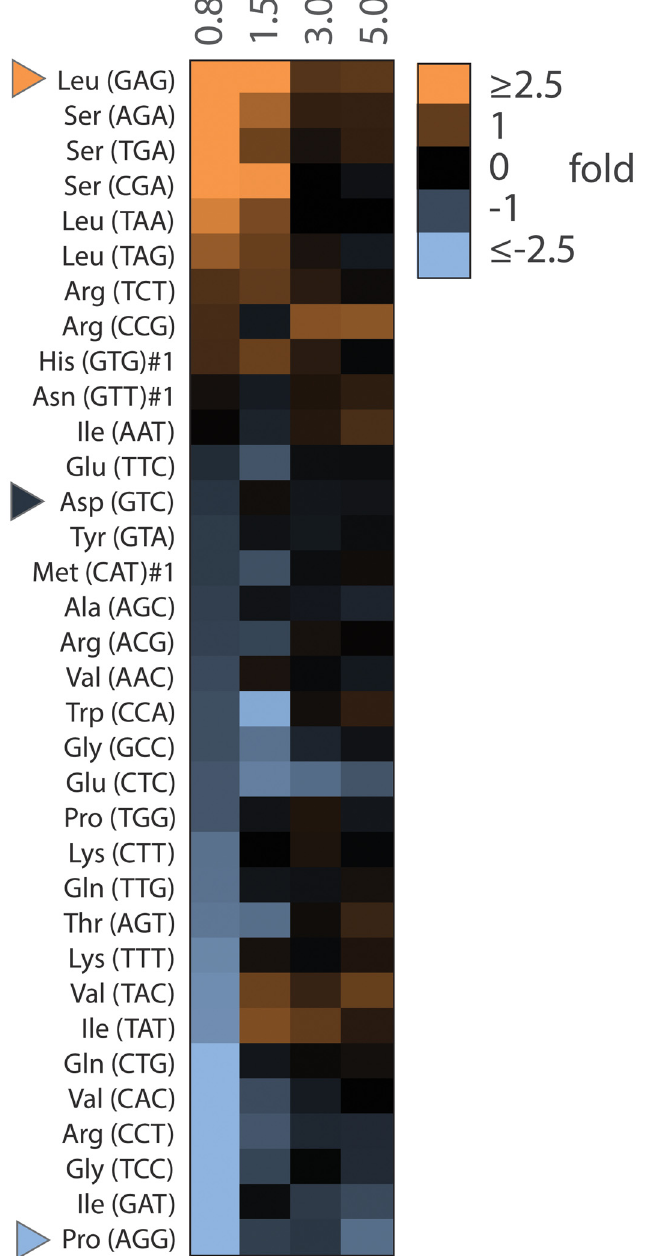
Fig 4. Relative abundance of complexed tRNAs. Data is shown for four enzyme concentrations all relative to total tRNAs. In other words, it corresponds for each probe, to the relative signal intensity in the complexed tRNA sample divided by the relative signal intensity in total tRNAs (EMSA input), expressed as fold differences. Red indicates an increase in relative amount whereas blue indicates a decrease. Data is organized from high to low relative abundance at 0.8 μ